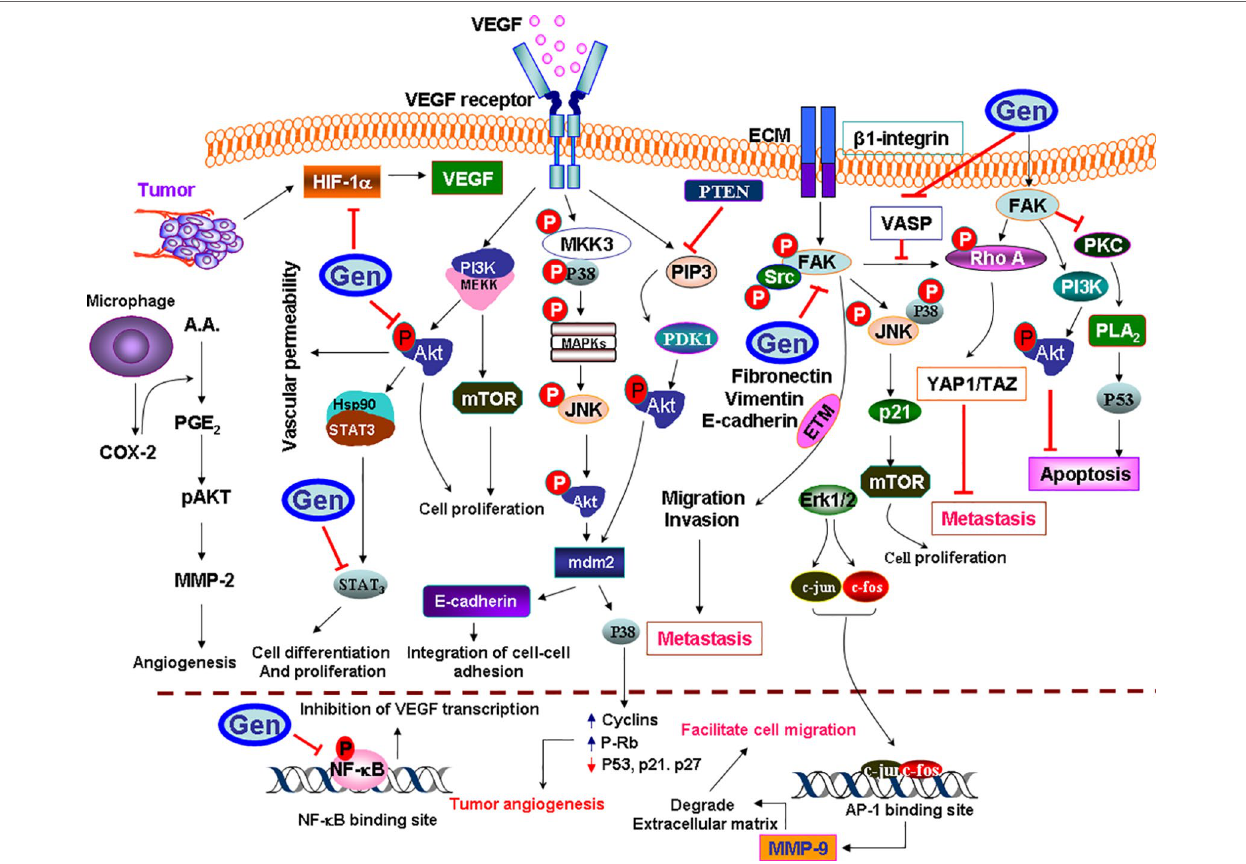
FIGURe 6 | Schematic representation of antiangiogenic activity of genistein (Gen) in cancer. Genistein inactivates each of mitogen-activated protein kinases (MAPK), activator protein-1 (AP-1), Akt/NF-κB, and Erk1/2 pathways, which abolished the downstream matrix metalloproteinase-9 (MMP-9) synthesis at the transcription level that declines the proteolytic activity and impairs the cellular migration. Although focal adhesion kinase (FAK) would prevent apoptosis through inactivation of the cytosolic phospholipase A2 (PLA2) and p53, but it would mediate apoptosis through the activation of PI3K/Act pathway. Genistein inhibits the activation of proangiogenic proteins (ERK/Akt/mTOR). Genistein could prevent cell differentiation and proliferation by increasing the activity of the tumor suppressor PTEN, which blocks Akt activation though PI3K dephosphorylation, and also dephosphorylate PIP3 into phosphatidylinositol 4,5-bisphosphate (PIP2). Genistein also prevents metastasis and enforces cancer cells to colonization in their site by phosphoprotein (VASP) upregulation. Since, VASP activates the extracellular matrix (ECM)- mediated β1-integrin-FAK-RhoA–YAP1-TAZ signaling to enhance YAP1/TAZ protein abundance. Genistein inactivates the epithelial–mesenchymal-transition (EMT) proteins, which promotes metastasis, including the proangiogenesis factors HIF-1α and vascular endothelial growth factor (VEGF), all are upregulated by hypoxia. Genistein downregulates PI3K/Akt/HIF-1α and NF-κB signaling pathways. Cycloxygenase-2 (COX-2) regulates the production of prostaglandin E 2 (PGE 2 ) from arachidonic acid (AA). PGE 2 -pAkt axis is involved in regulation of MMP-2 activity, which, in turn, induces angiogenesis.